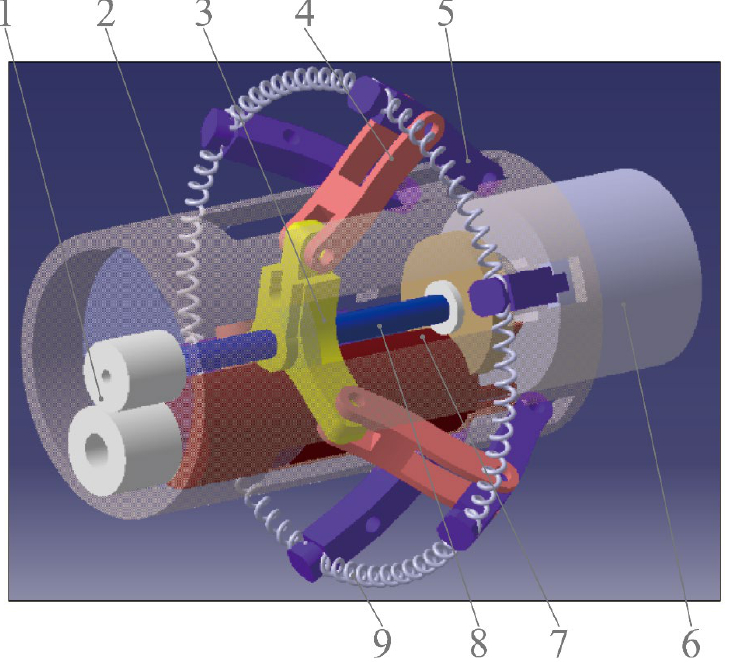
Figure 1. Structure of capsule robot. 1. Gear pair, 2. Shell, 3. Nut slider, 4. Brace bar, 5. Leg, 6. Radially magnetized magnet, 7. Micro-DC, motor 8. Lead screw, 9. Spring.